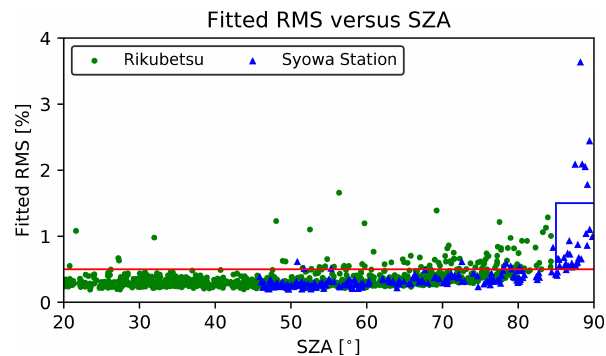
Figure 6. The fitted rms residuals vs. the SZA values for an indi- vidual retrieval. The rms values at Rikubetsu and Syowa Station are shown by green circles and blue triangles,